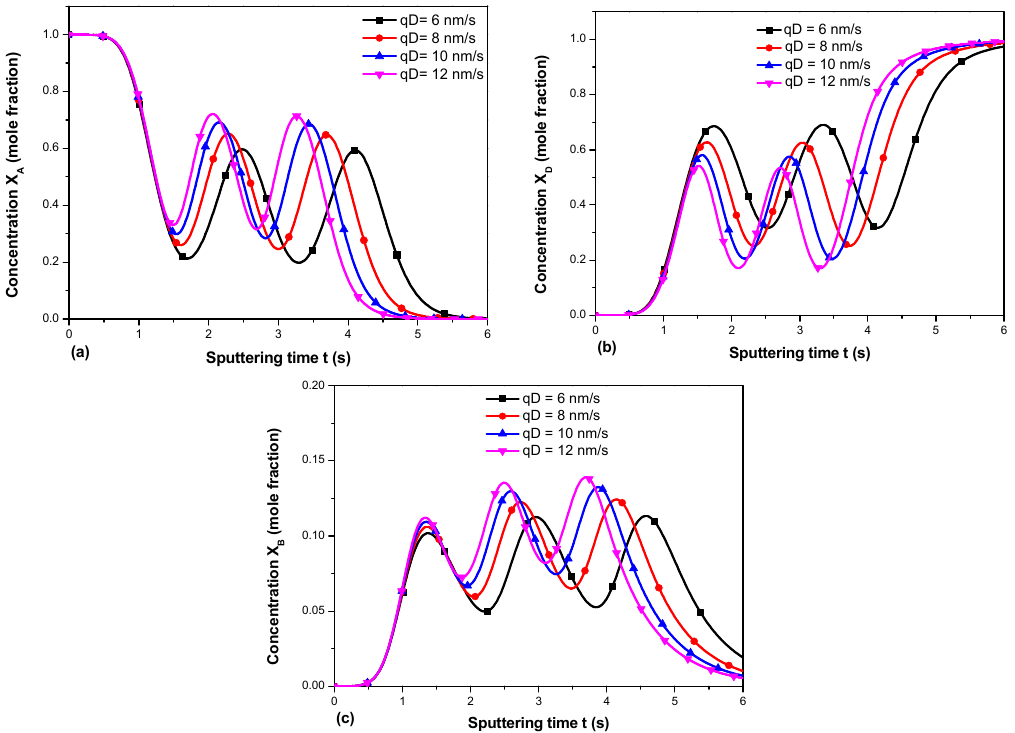
Figure 3. The simulated time-concentration profiles of multilayers: ( a ) component A; ( b ) component D; and ( c ) component B, for different sputtering rates of element D with a constant thickness of delta layer as indicated inset.